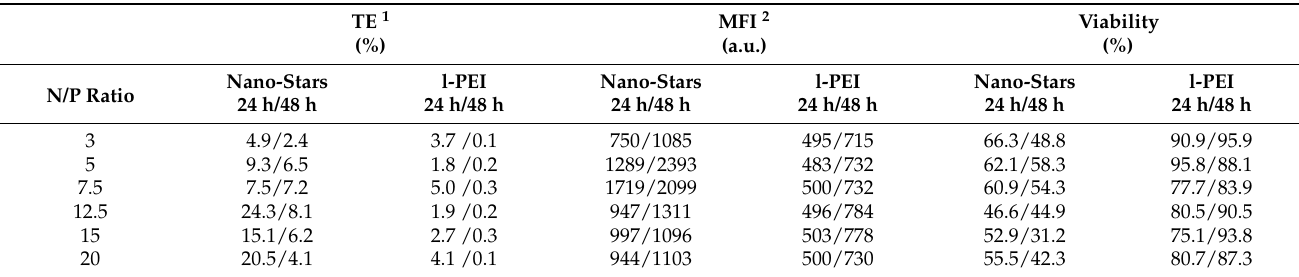
Table 1. Transfection of human primary B cells with PDMAEMA-nano-stars and l-PEI using the standard transfec- tion method.